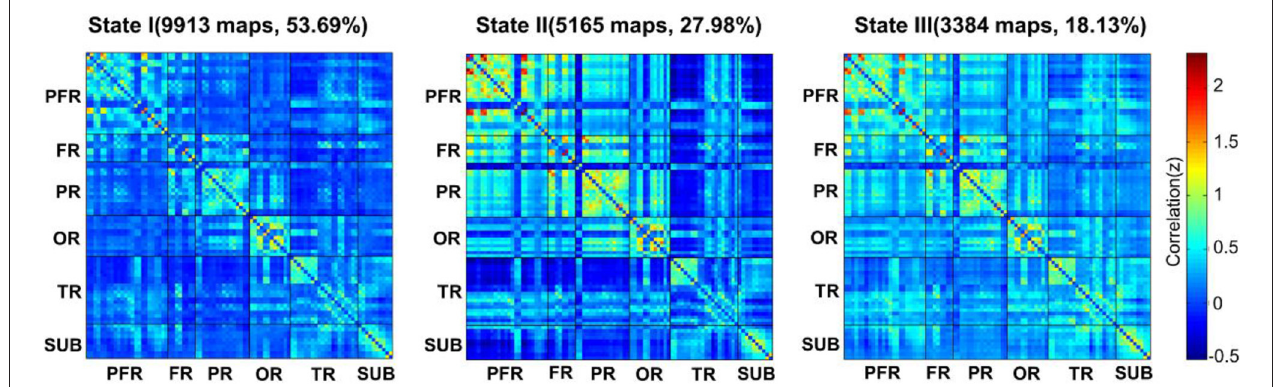
FIGURE 1 | The total numbers and percentages of three state occurrences in all subjects. PFR, prefrontal region; FR, other regions of the frontal lobe; PR, parietal region; OR, occipital region; TR, temporal region; SUB, subcortical region.